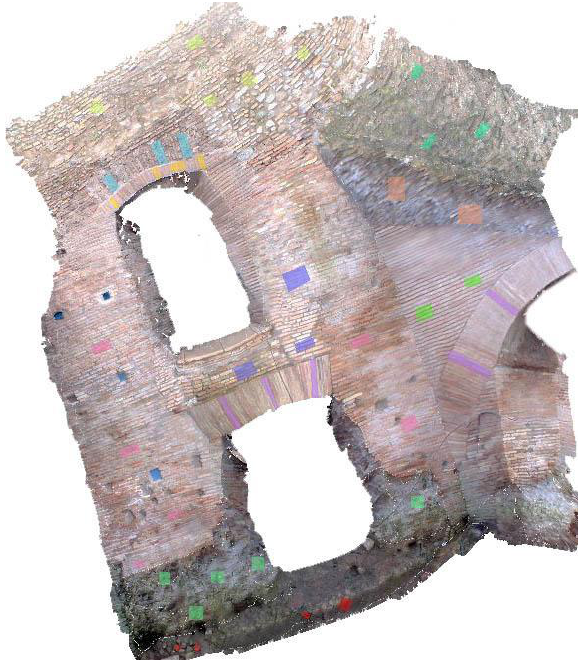
Figure 7: Manually identified training areas (11 classes) on the unwrapped texture of the Circus’s